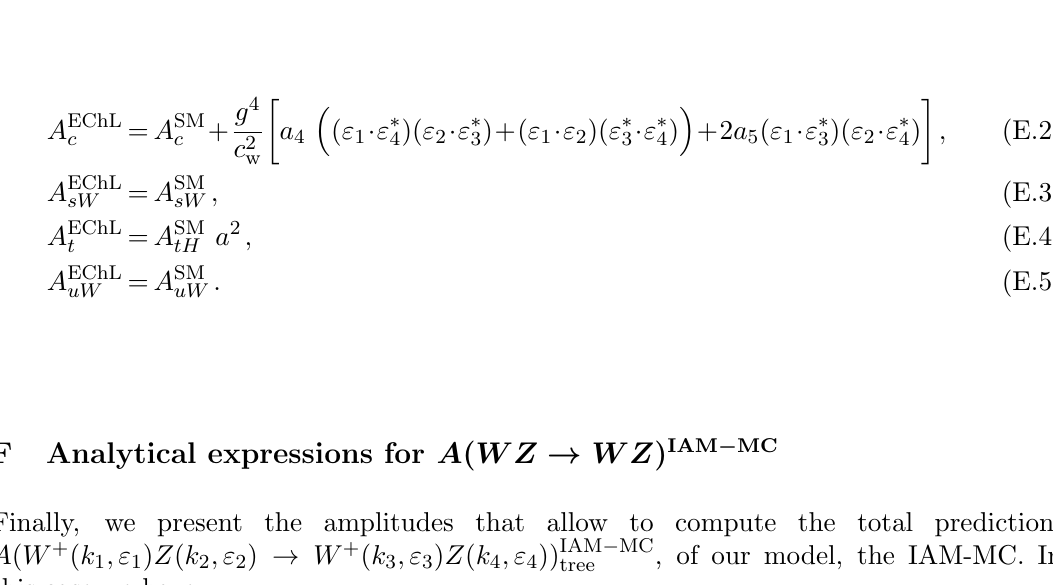
Figure 22 . Feynman diagrams that contribute to the A ( WZ and in the unitary gauge. Gray circles represent vertices that are sensitive to the chiral parameters a; a 4 and a 5 of our simpli(cid:12)ed